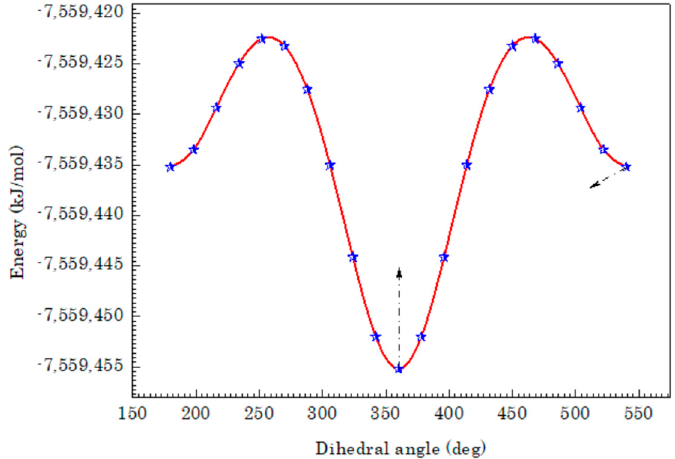
Figure 1. The PE curve of 3-Br-2-HyP along the N5–C2–O6–H10 dihedral angle.